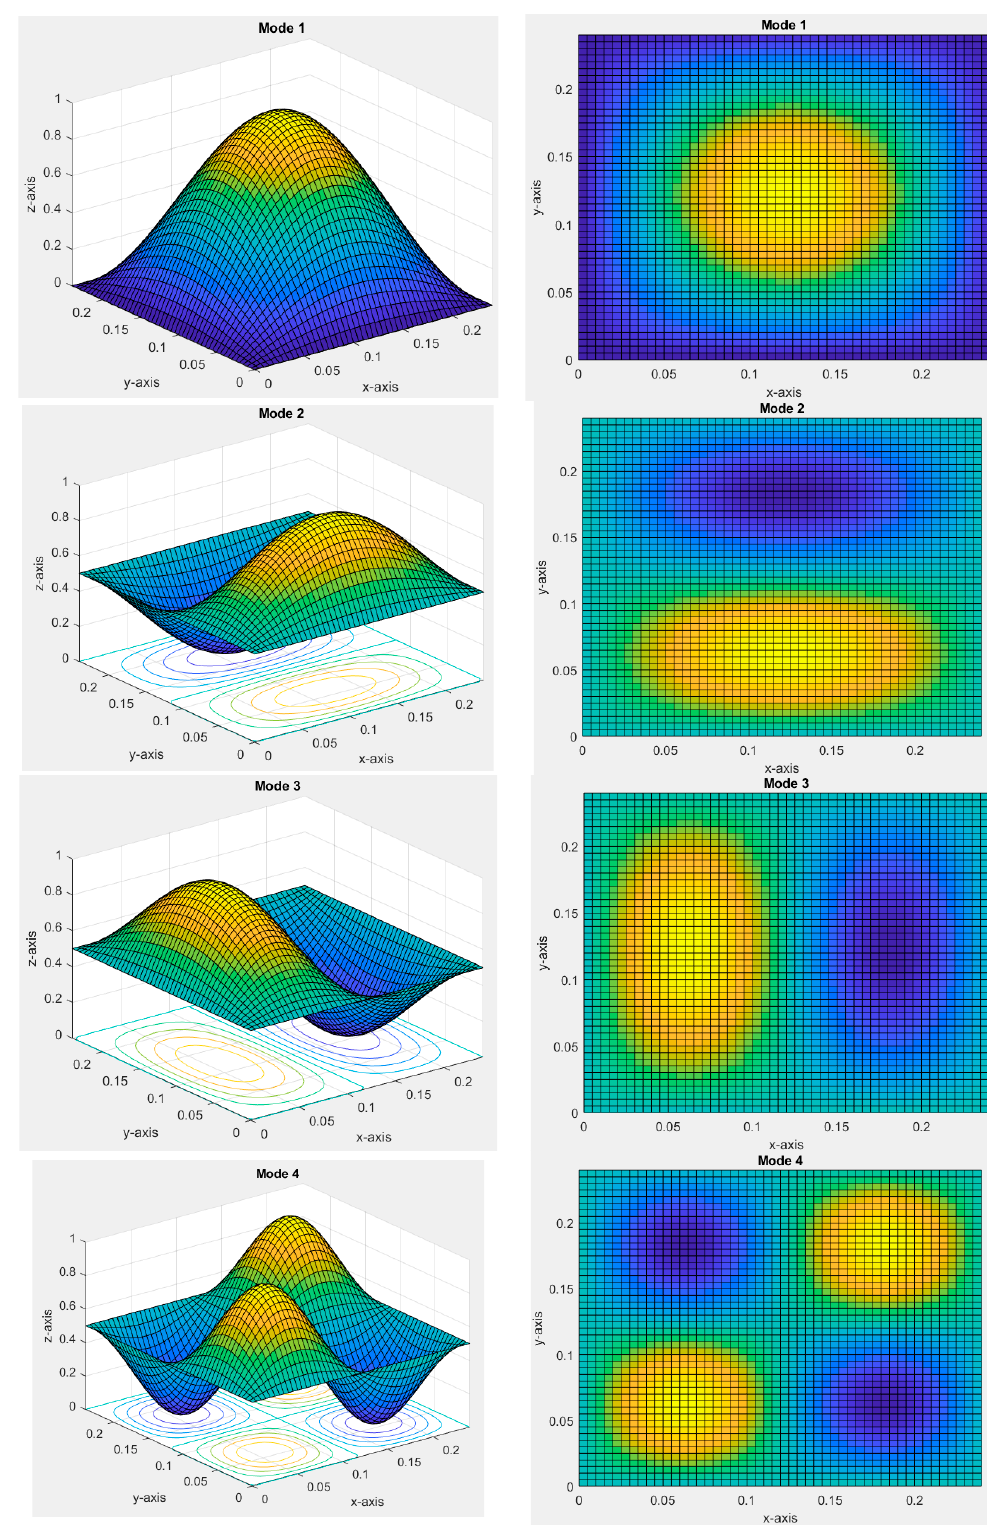
Figure 5. First four mode shapes of the square sandwich plate ( a / h = 20) in MATLAB.